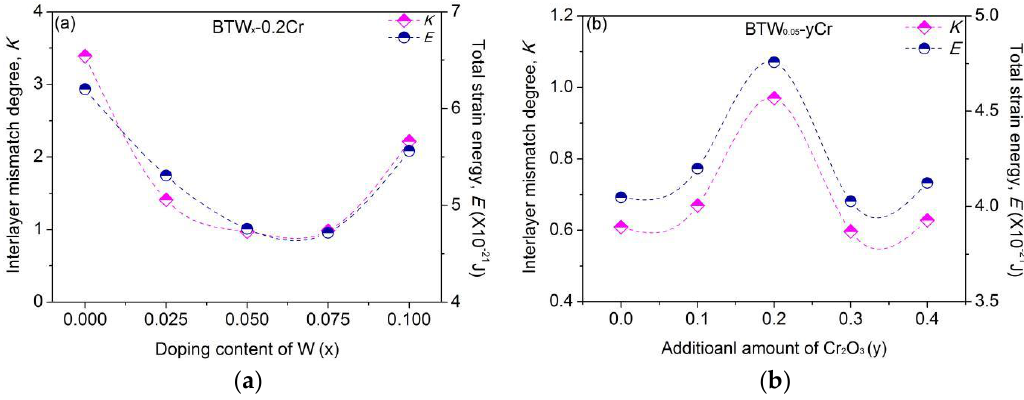
Figure 7. Variation of the interlayer mismatch degree and total strain energy of BTWC with the composition ( a ) varying with the doping content of W ( x ); ( b ) varying with the additional amount of Cr 2 O 3 ( y ).